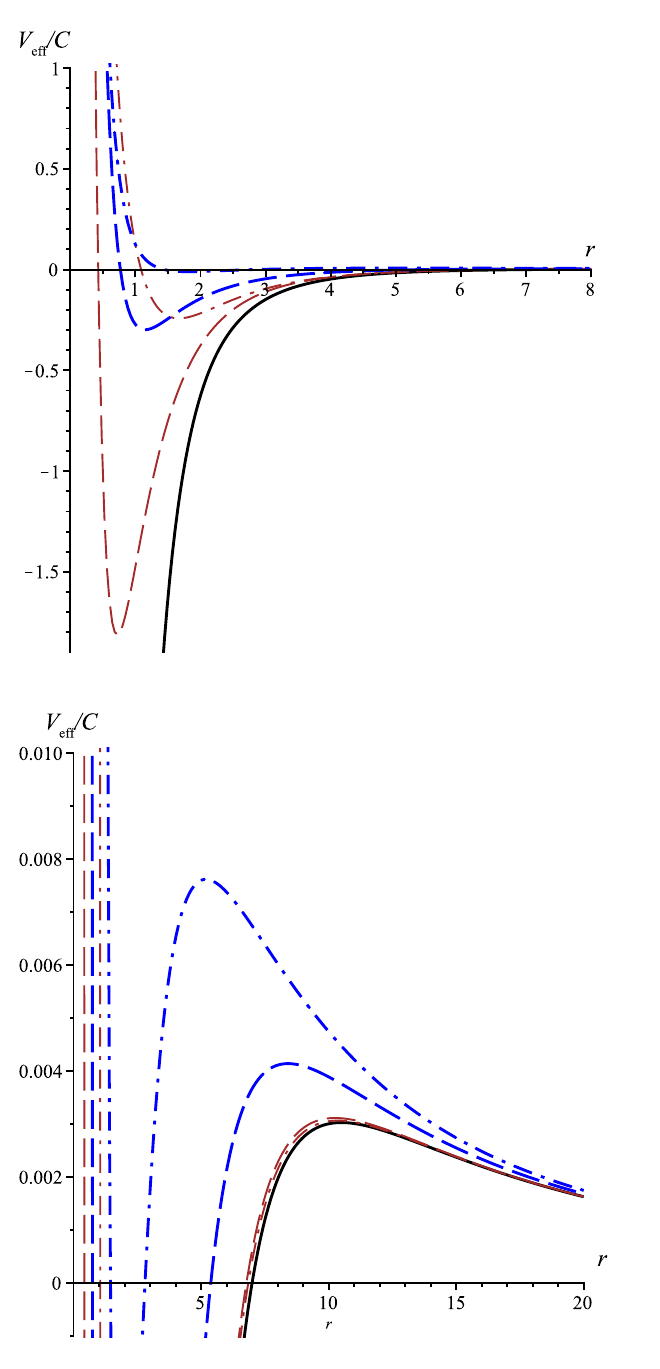
Figure 7 . The effective potential (3.91) for null geodesics with C > 0 for the Schwarzschild (thick solid), Bardeen (thin dashed), Hayward (thin dash-dotted), Dymnikova (thick dashed), and Fan- Wang black holes (thick dash-dotted) with m = 3 . 5 and l = 1